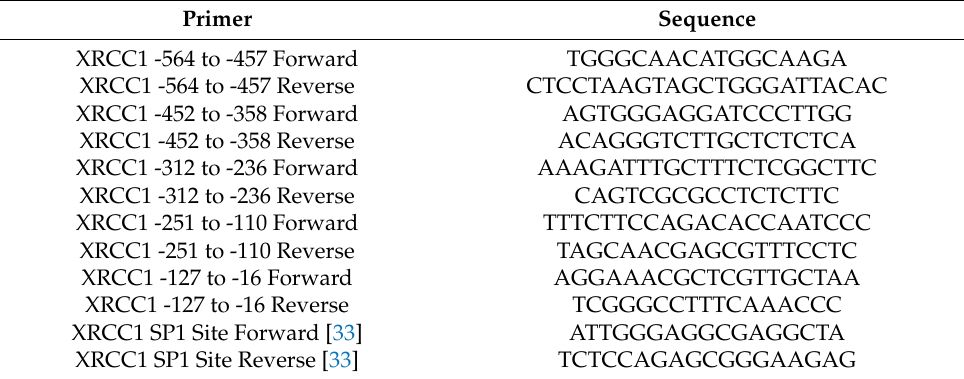
Table 2. Chromatin Immunoprecipitation